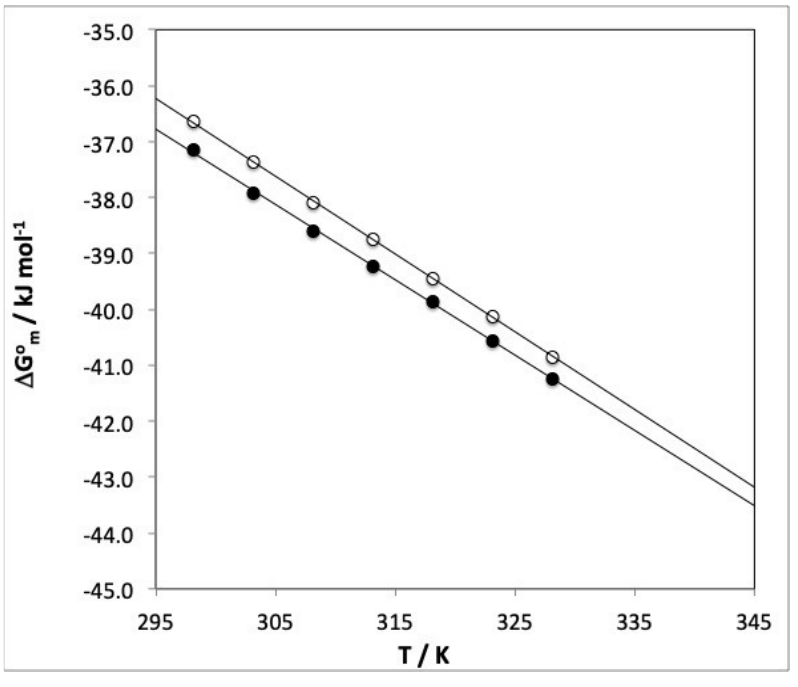
Figure 3. Influence of T (K) on ∆ G 0 m (kJ mol −1 ) for SDS–CA. Caffeic acid concentration: ( ) 30 × 10 − 5 mol kg − 1 , ( ) 1.5 × 10 − 5 mol kg − 1 . (cid:35) Table 3. ∆ H 0 m (kJ mol − 1 ) and ∆ S 0 m (kJ mol − 1 K − 1 ) for the SDS–caffeic acid system as calculated from the variation of ∆ G 0 m with T . The uncertainly values are below 10%.